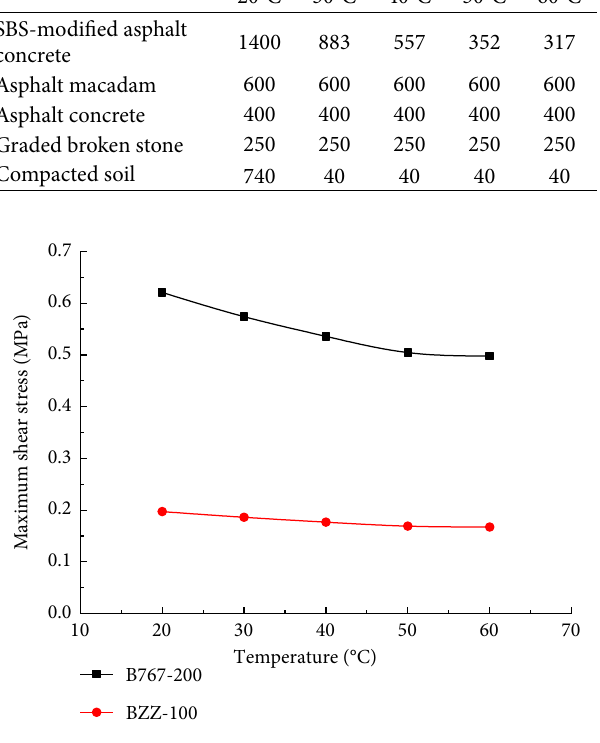
Figure 8: Effect of temperature on the maximum shear stress of